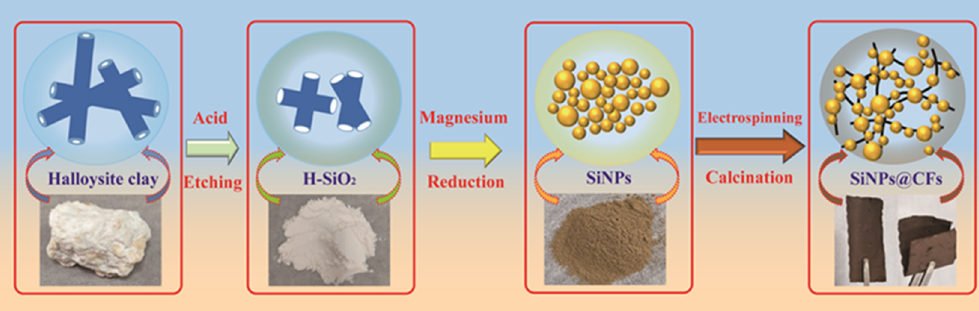
Figure 2. Schematic of SiNPs@CFs preparation process.